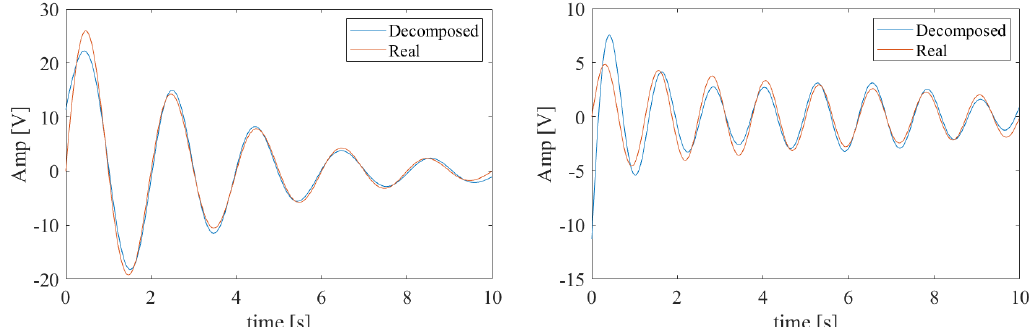
Figure 3. Mono-components obtained from the signal of Equation (17), setting the bisecting frequency equal to the average frequency; low frequency signal ( on the left ) and high frequency signal ( on the right